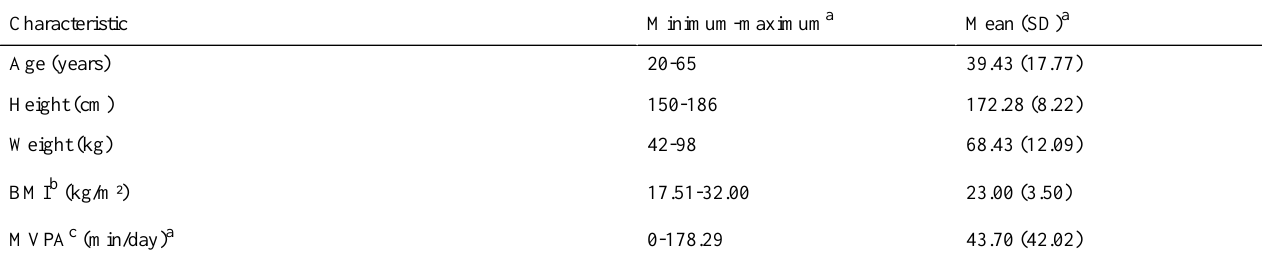
Table 1. Participant characteristics (N=36).